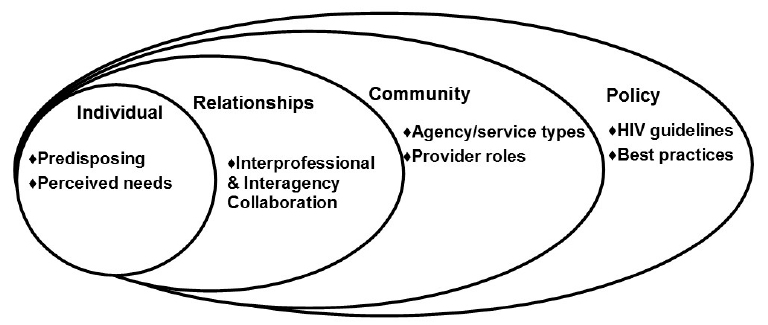
Figure 1. Socioecological influences on human immunodeficiency virus (HIV) continuum of care.